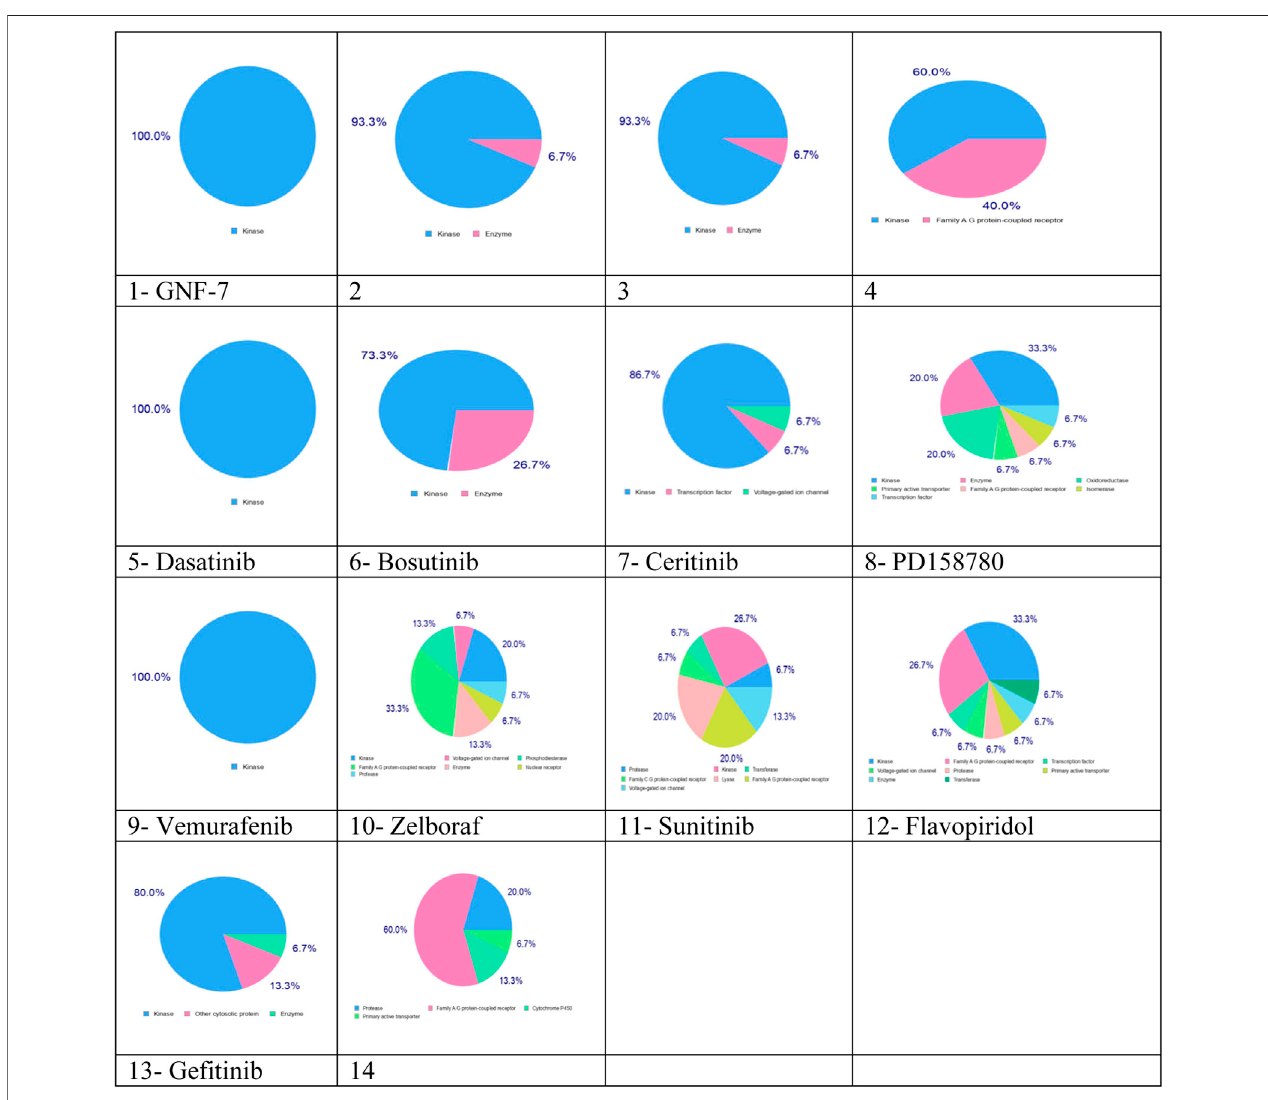
FIGURE4| Predictedbiologicaltargetsfor14multikinaseinhibitorsusingtheSwissTargetPredictiononlinetool.Bluecolor:kinase,pink:familyAGprotein-coupled receptor, light green: voltage-gated ion channel, light pink: protease, green: transferase, light blue: transcription factor, and yellow: primary active transporter.